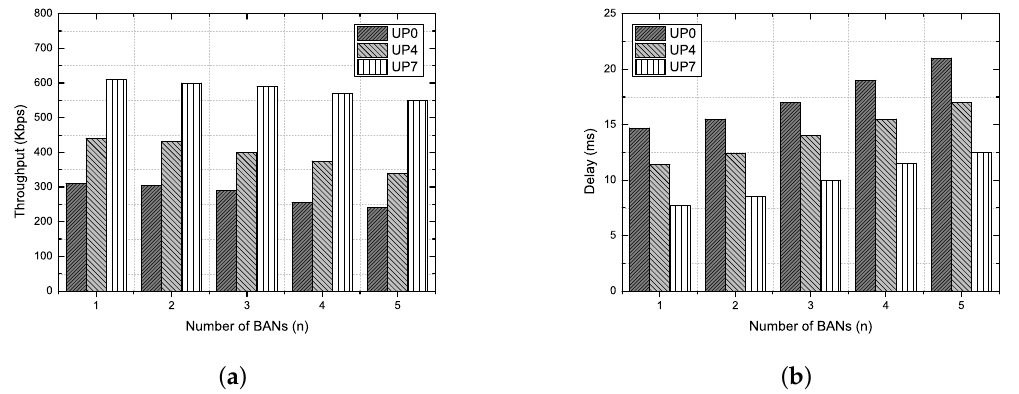
Figure 15. Performance comparison for different numbers of BANs in scenario 2: Impact of varying numbers of BANs on the ( a ) throughput and ( b ) average